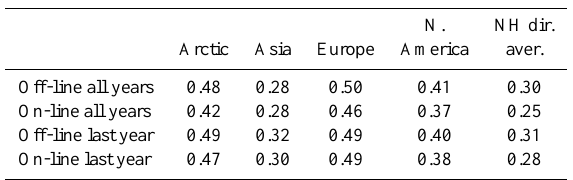
Table 3. Northern Hemisphere rms errors between simulations and proxy-based reconstructions for the analysis and the ensemble mean of the two data assimilation schemes.